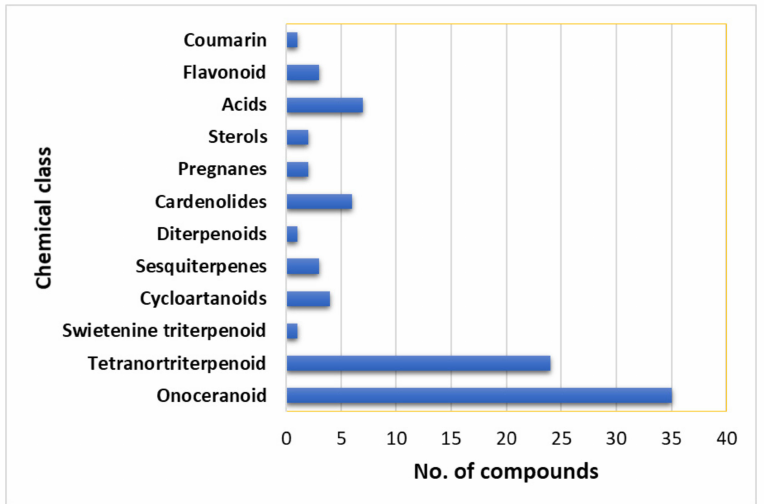
Figure 12. Number of metabolites reported from Lansium domesticum and their chemical classes. These metabolites were isolated from the different parts of L. domesticum such as seeds, leaves, peels, bark, twigs, and fruits (Figure 13). Triterpenoids (64 compounds) are the major metabolites reported from L. domesticum , including onoceranoid (35 compounds), tetranor- triterpenoid (24 compounds), cycloartane (4 compounds), and swietenine (1 compound) triterpenoids and are frequently involved in various pharmacological